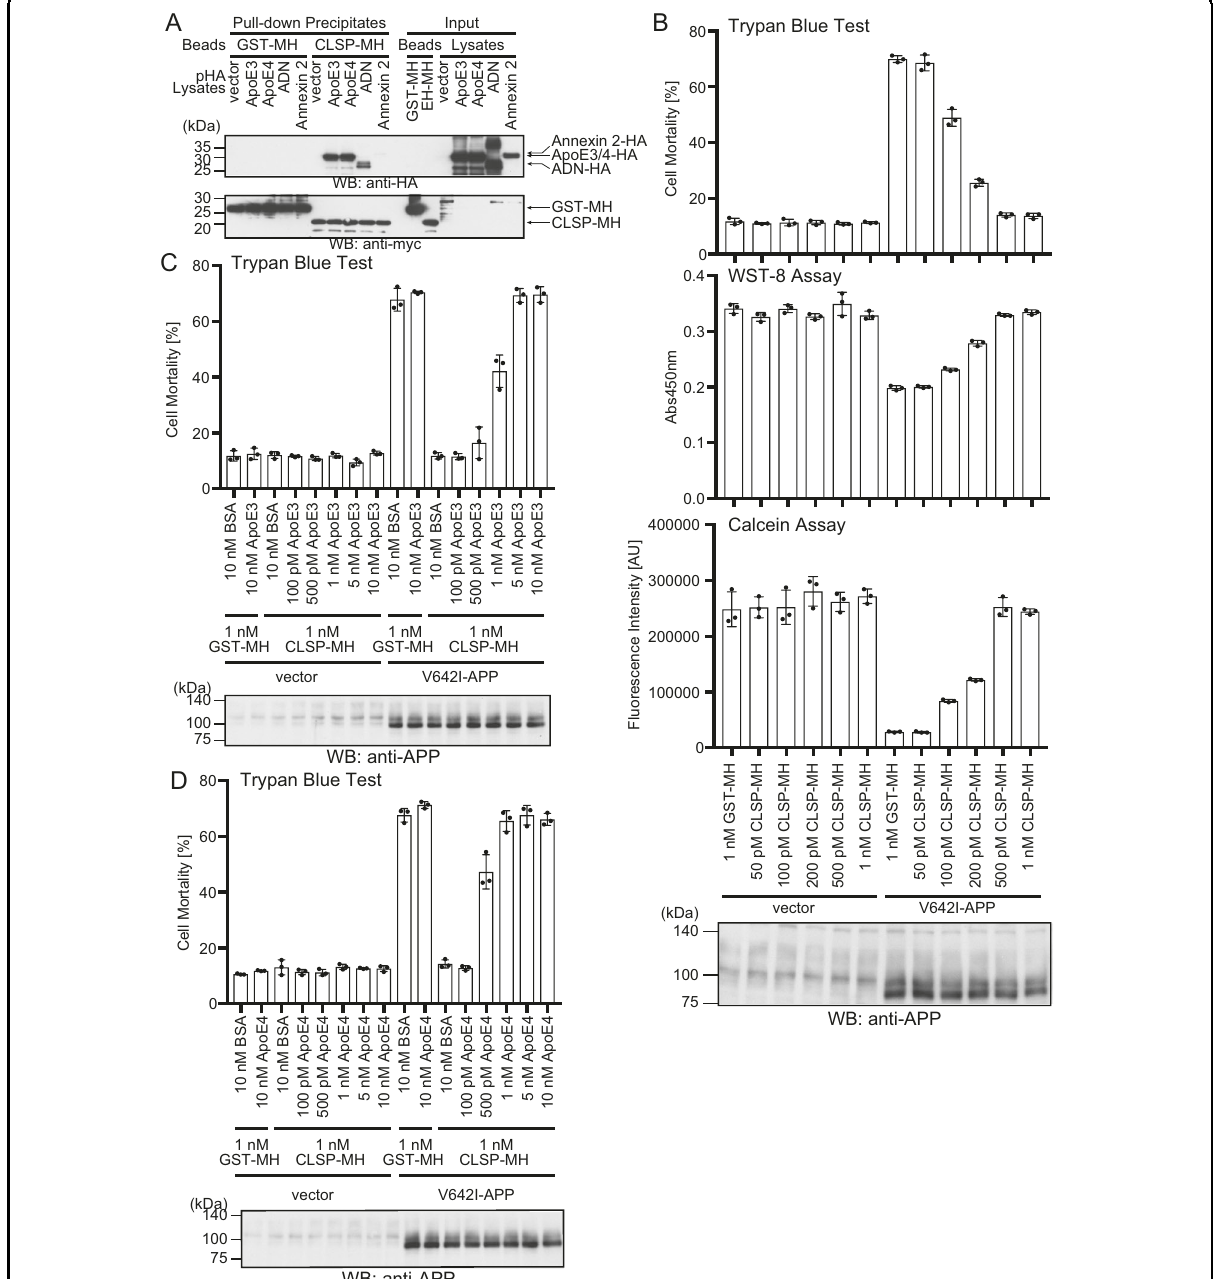
Fig. 1 Apolipoproteins E suppresses CLSP activity. a ApoE3, E4, adiponectin (ADN), and annexin 2, C-terminally tagged with HA, were overexpressed in F11 neurohybrid cells. Resulting cell lysates were mixed with bacterially produced GST-MycHis- or CLSP-MycHis-conjugated sepharose 4B and incubated at 4 °C overnight. The pulled-down precipitates were immunoblotted using HA and myc antibodies. For reference, inputs including the sepharose 4B beads conjugating GST-MycHis (GST-MH) and CLSP-MycHis (CLSP-MH) and the cell lysates were similarly immunoblotted. b SH-SY5Y cells, transfected with the empty vector or pcDNA3.1/MycHis-V642I-APP, were cultured in the presence of indicated concentrations of CLSP-MycHis. At 48 h, cells were harvested for trypan blue exclusion cell mortality assays (Trypan Blue Test) and cell viability assays using the WST-8 assay kit or staining with calcein AM. Cell lysates were immunoblotted using the APP antibody. c , d SH-SY5Y cells, transfected with the vector or pcDNA3.1/MycHis-V642I-APP, were cultured in media containing 1 nM of GST-MycHis or CLSP-MycHis with/without indicated concentrations of BSA, ApoE3 ( c ), or ApoE4 ( d ). At 48 h, cells were harvested for trypan blue exclusion assays. Cell lysates were immunoblotted using the APP